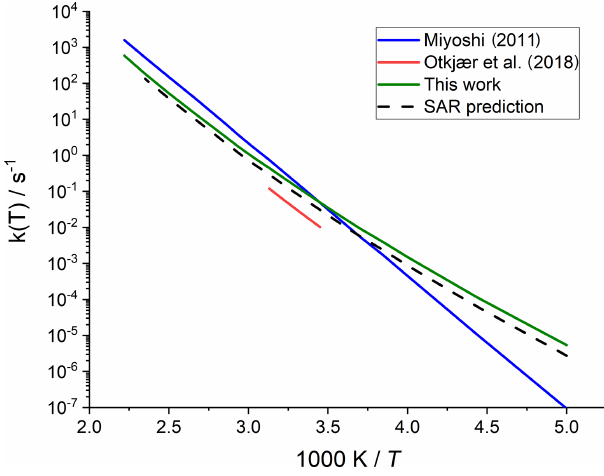
Figure 1. Rate coefficient for 1,5-H migration in an aliphatic alkyl (cid:113) peroxy radical with a > CH(OO ) radical group and a tertiary (– CH < ) migrating H atom. The SAR derivation matches a geomet- ric average at 298K and uses the most reliable temperature depen- dence, accounting for tunnelling at low temperatures.